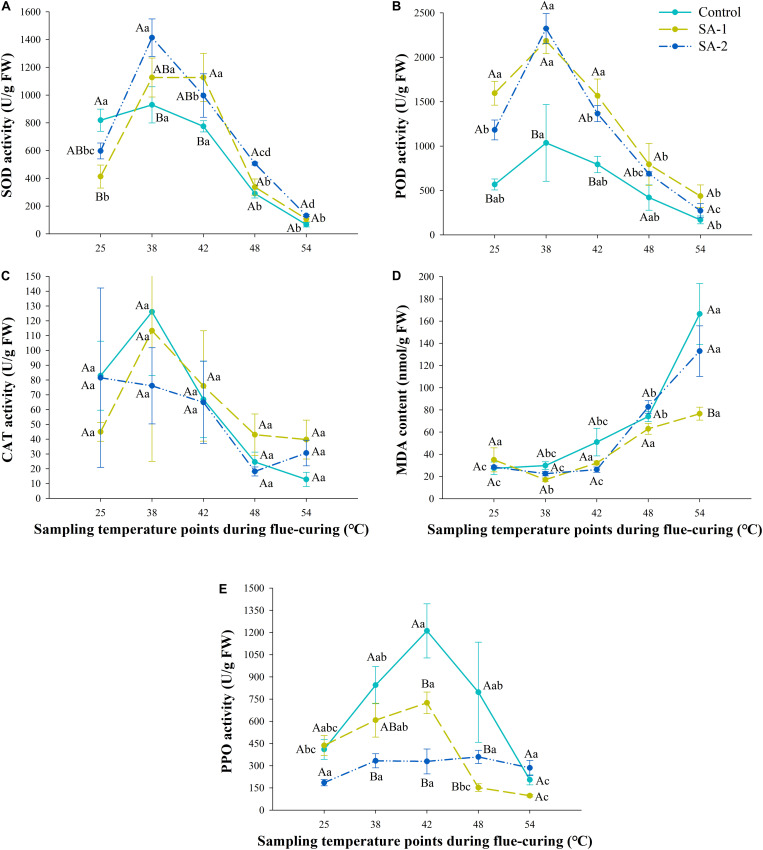
Antioxidant enzyme system and polyphenol oxidase activity during bulk curing of flue-cured tobacco with different salicylic acid concentrations. (A) Effect of treatment with different salicylic acid concentrations on SOD activity at different curing stages. (B) Effect of treatment with different salicylic acid concentrations on POD activity at different curing stages. (C) Effect of treatment with different salicylic acid concentrations on CAT activity at different curing stages. (D) Effect of treatment with different salicylic acid concentrations on the content of MDA at different curing stages. (E) Effect of treatment with different salicylic acid concentrations PPO activity at different curing stages. Different capital letters indicate significant differences between treatments at the same stage (P < 0.05). Different lowercase letters indicate significant differences between the same treatments at different curing stages. Data are presented as means ± standard error (n = 3).